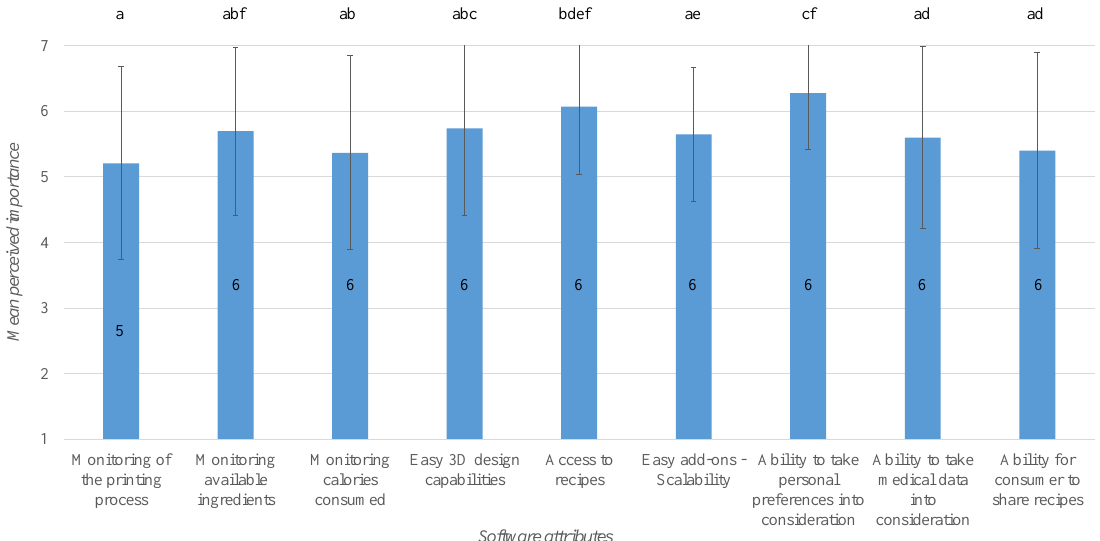
Figure 5. Bar plot of means for perceived importance of 3D food printer software attributes. Error indicates the standard deviation, and the number inside the bars indicates median. Bars sharing the same letter are not significantly different according to Wilcoxon signed rank